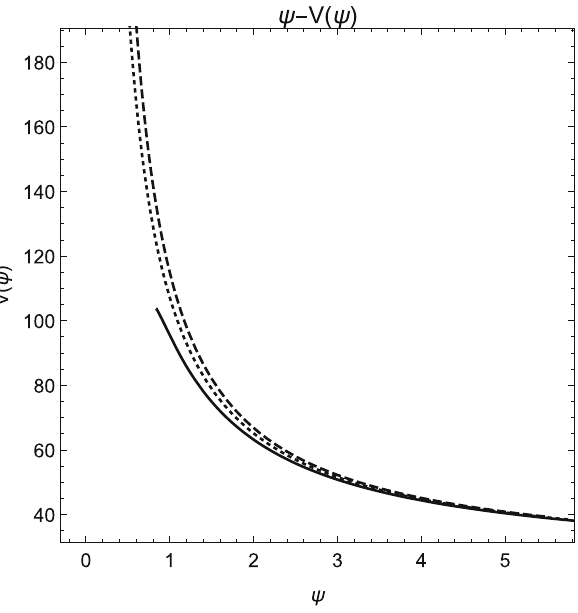
Fig. 2 Qualitative behaviour of the scalar field potential V (ψ) for various values of the free parameters ψ 1 , ψ 2 . Solid line is for (cid:9) (cid:10) (ψ ,ψ , 1 1 ) = , dotted line is for (ψ 1 ,ψ 2 ) = 1 2 (cid:9) (cid:10) 2 2 , − 1 1 for (ψ 1 ,ψ 2 ) = . From the plots we observe that the potential 2 2 behaves like a power-law function. The plots are for θ 0 = 1 , ζ = 1 and c θ = 6and a 2 = 1 . Thepotentialisforthescalefactor a ( t ) = a 0 t α 1 e α 2 t